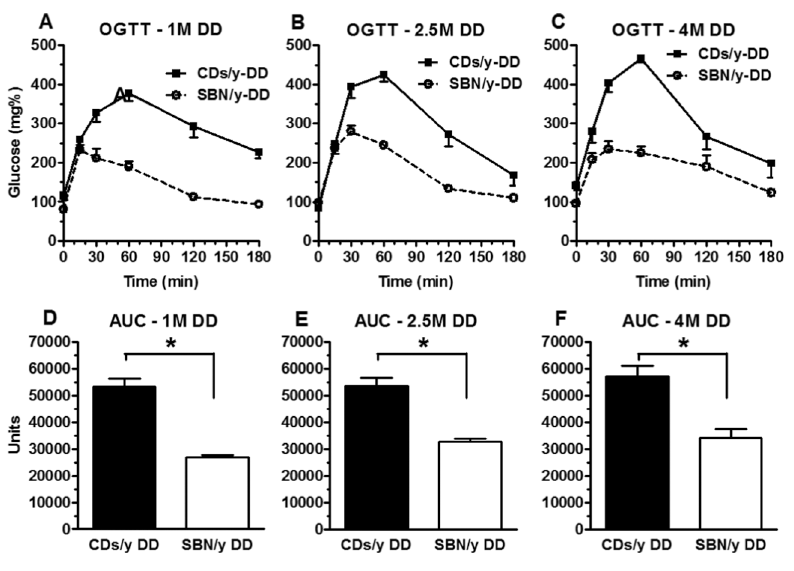
Figure 2. Results of the OGTT in F2 after 1, 2.5 and 4 months of feeding with DD. Data are presented as scattergram of the AUC of individual animals, as well as mean ±